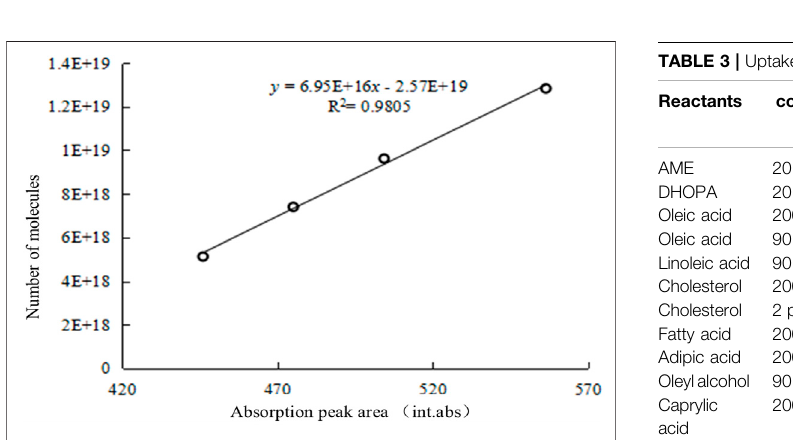
FIGURE8 | Standard curve ofnumber ofAMEmolecules vs. absorption peak area at 3,480 cm − 1 .